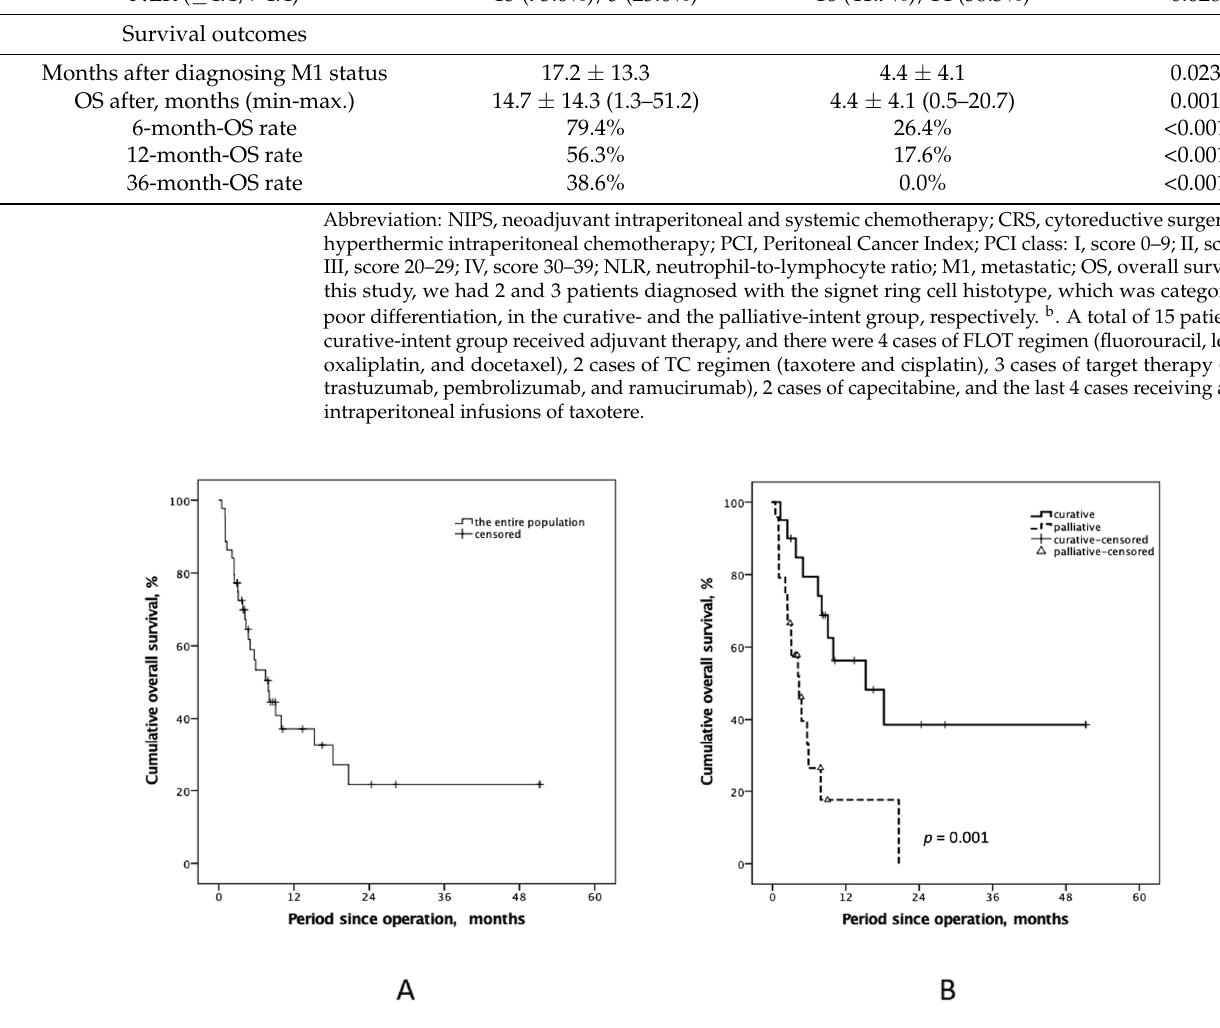
Figure 3. Kaplan–Meier plots of overall survival (OS) rate according to ( A ) the entire study population and ( B ) by curative- and palliative-intent. The OS rate of the curative-intent group was significantly superior, compared with the palliative group ( p = 0.001).